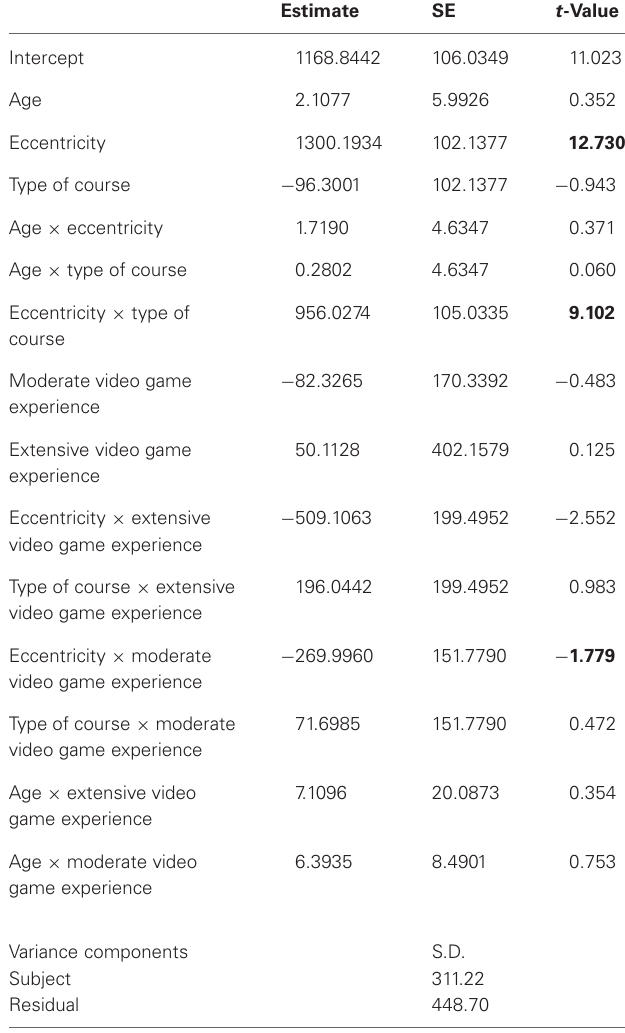
Table 3 | Linear mixed model for median manual reaction time (significant effects with t -value ± 2 in